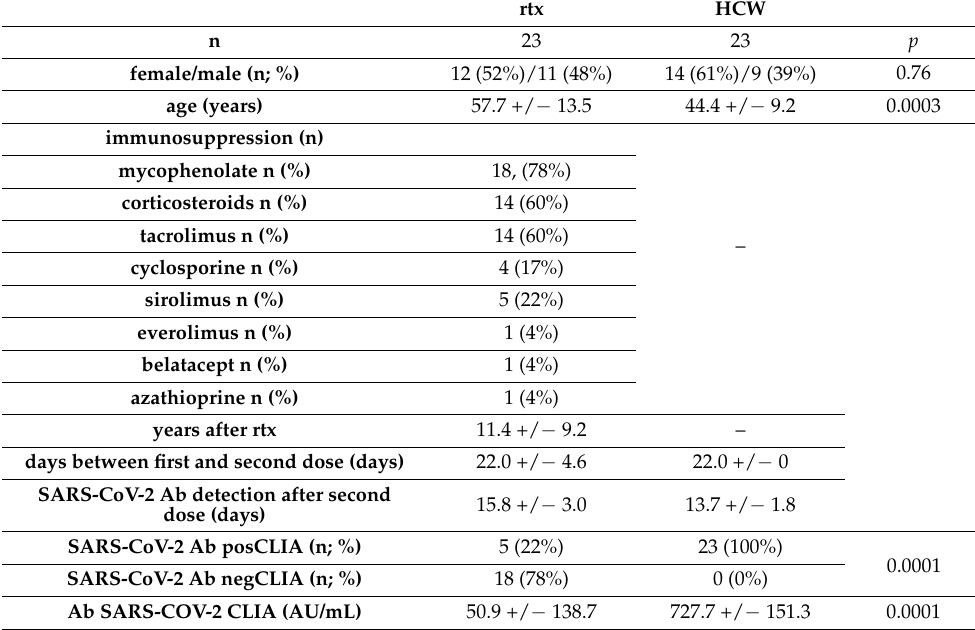
Table 1. Characteristics of patients after renal transplantation and healthcare workers after two doses of the mRNA-based SARS-CoV-2 vaccine BNT162b2. rtx renal transplant recipients; HCW, healthcare workers; n number; pos positive; neg negative; Ab antibody, CLIA Chemiluminescence Enzyme Immunoassays; AU Arbitrary Units; mL milliliter; Ab antibody.